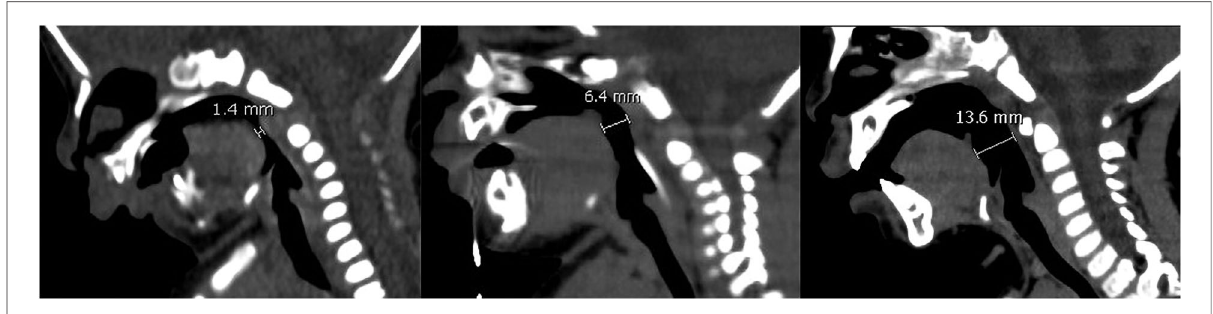
FIGURE 2 From left to right are CT images on preoperative day 1, postoperative day 28, postoperative 1 year 2 months. CT images showed the distance between the base of tongue and posterior pharynx wall was 1.4 mm, 6.4 mm, 13.6